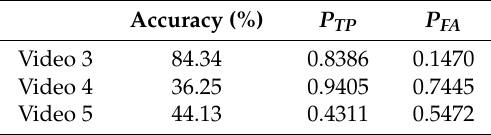
Table 4. Classification results for the second dataset at resolution of 224 × 224 (Experiment